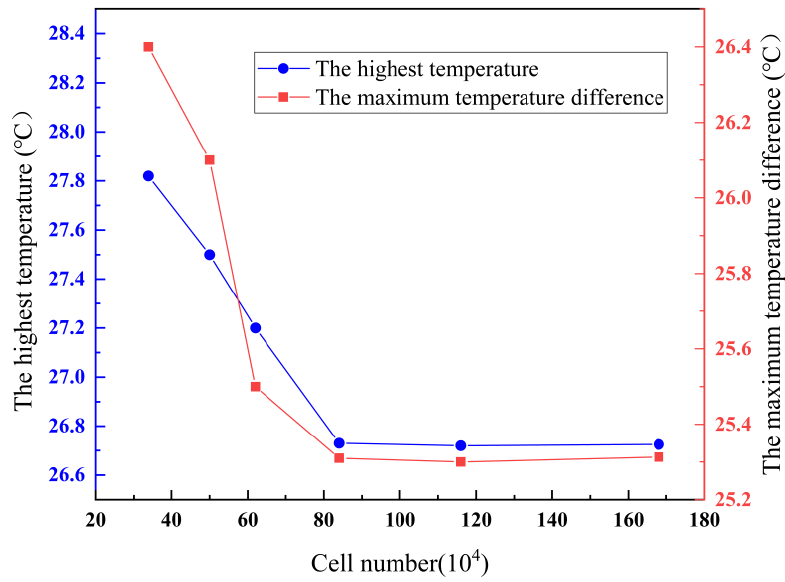
Figure 5. Grid dependency test.